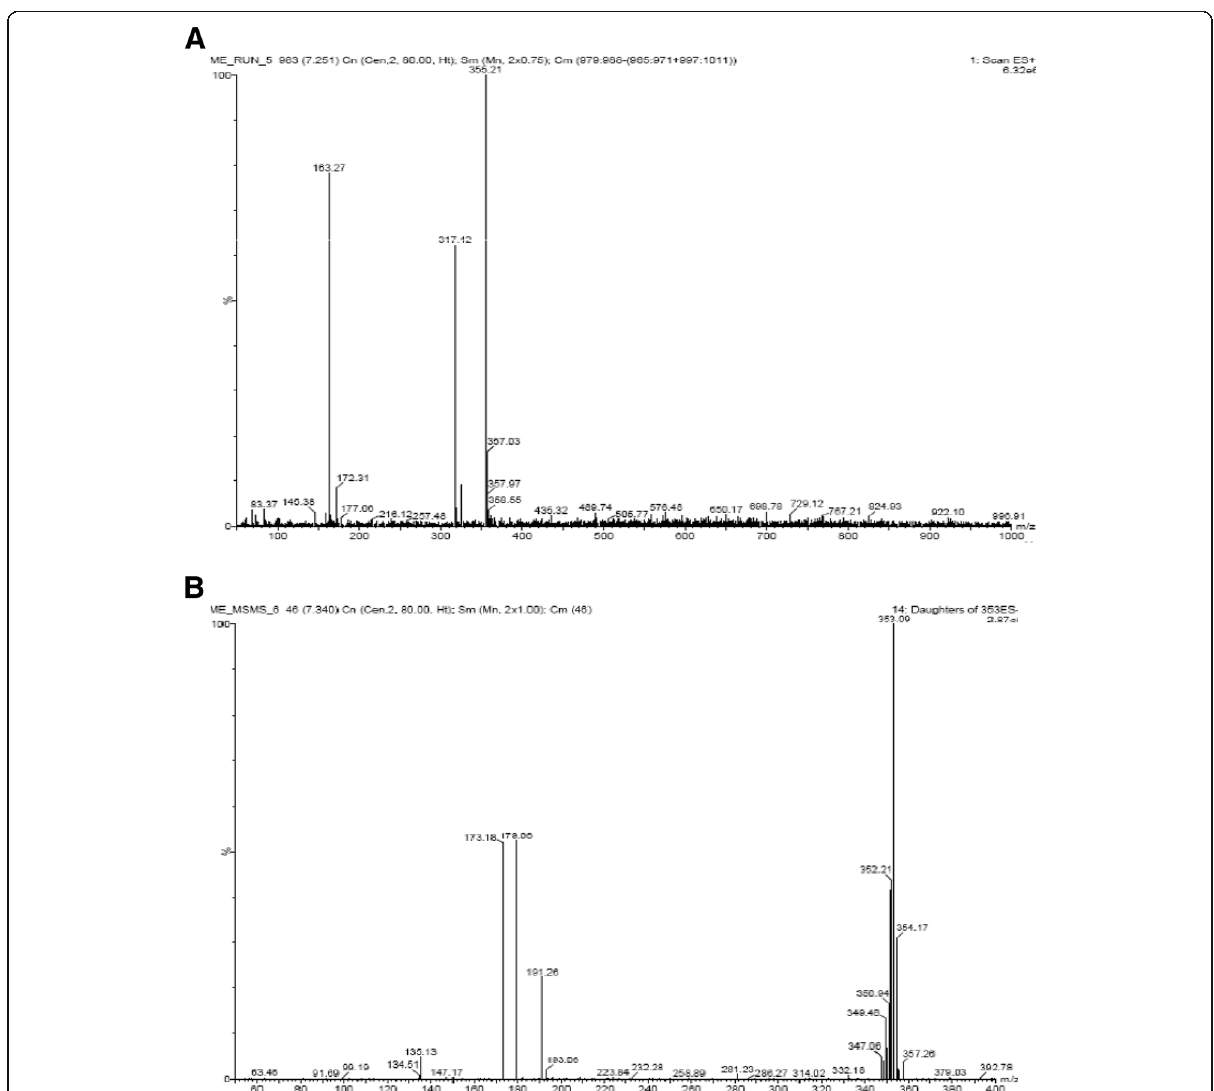
Fig. 1 UPLC-MS/MS analysis shows chlorogenic acid fragmentation pattern in both positive and negative ion mode ( 1a . Positive [M - H] + , 1b . Negative [M - H] ˉ ion